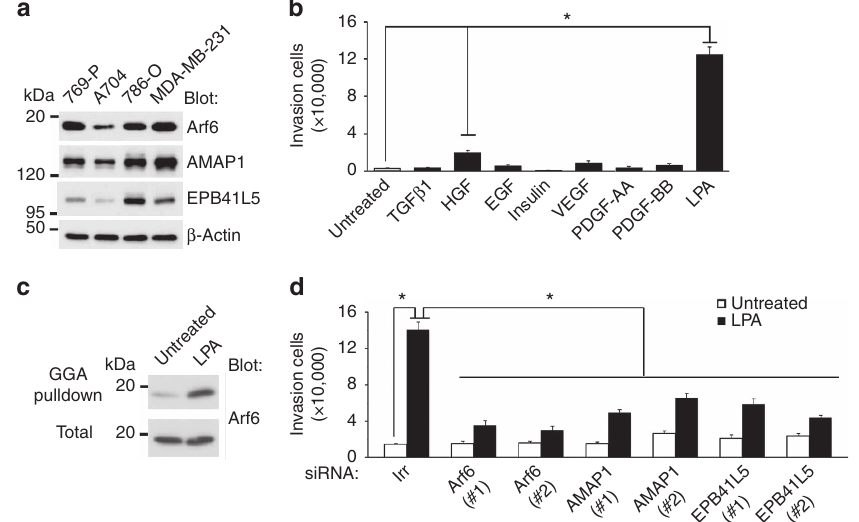
Figure 1 | LPA activates Arf6 to promote the invasion of 786-O cells. ( a ) The expression of Arf6 pathway proteins in ccRCC cell lines, assessed by immunoblotting analysis of total cell lysates using the indicated antibodies. Lysates of MDA-MB-231 cells were included for comparison. b -actin immunoblotting is shown as a control. ( b ) Matrigel invasion activities of 786-O cells in the presence of various ligands, as indicated. ( c ) Arf6 activity of 786-O cells on stimulation by LPA. ( d ) Requirement for Arf6, AMAP1 and EPB41L5 in LPA-induced Matrigel invasion of 786-O cells, as assessed by their gene silencing using specific siRNAs. ( b , d ) Error bars show the mean ± s.e.m., n ¼ 3. * P o 0.01. Statistical analyses were performed using analysis of